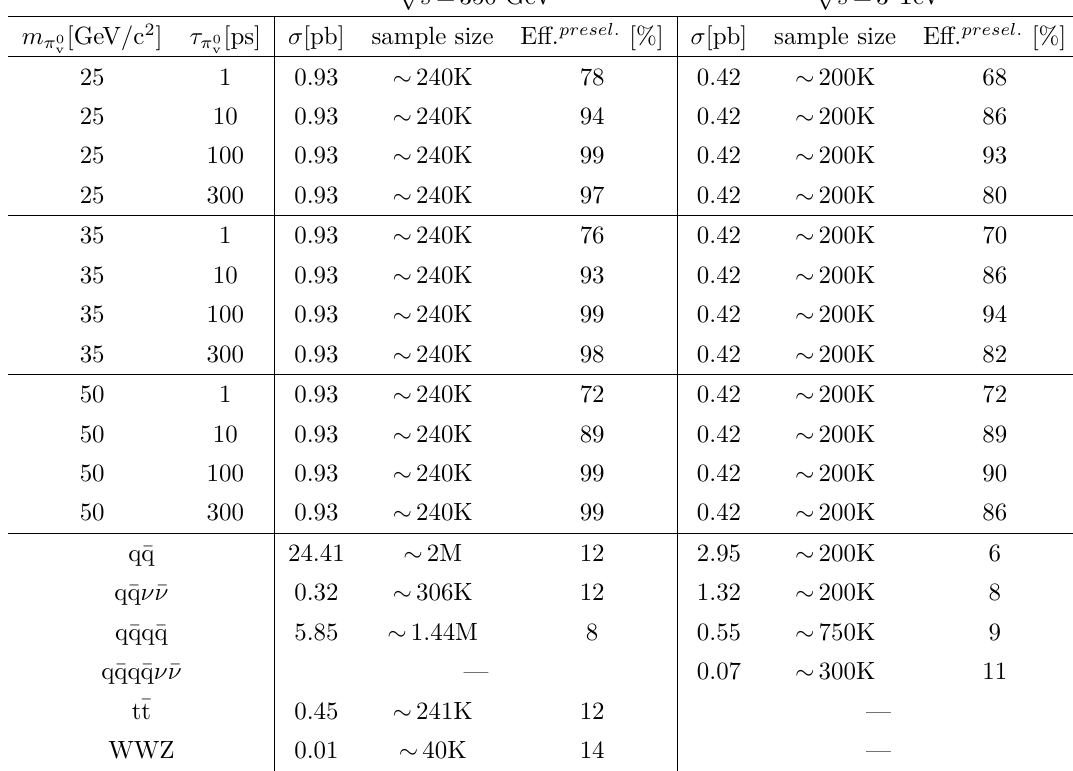
Table 1 . Signal and background Monte Carlo samples. Eff. presel. is the preselection efficiency denoting the efficiency of the events with at least two displaced vertices reconstructed and a b -tag probability larger than 0.95 for all reconstructed jets (see section